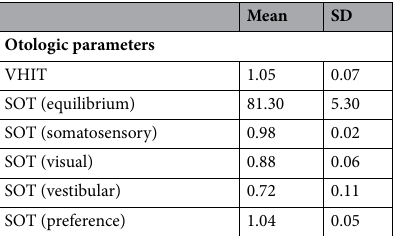
standard deviation of NN, RMSSD the root mean square of the successive differences, TBUT tear breakup time, VHIT video head impulse test, SOT sensory organization